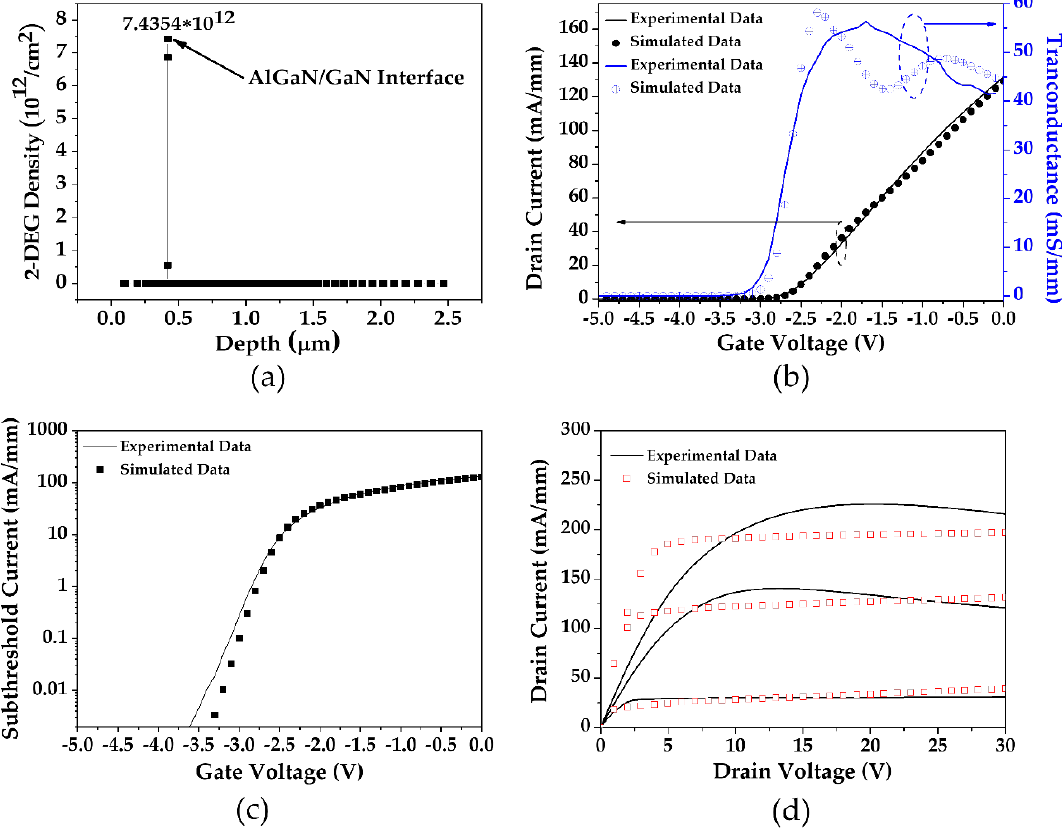
Figure 3. ( a ) The two-dimensional electron gas (2-DEG) density at the AlGaN/GaN interface; ( b ) transfer current–voltage characteristics of the measured and simulated devices at V ds = 25 V; ( c ) subthreshold drain leakage current on log scale, and ( d ) saturation currents of the fabricated and simulated devices.